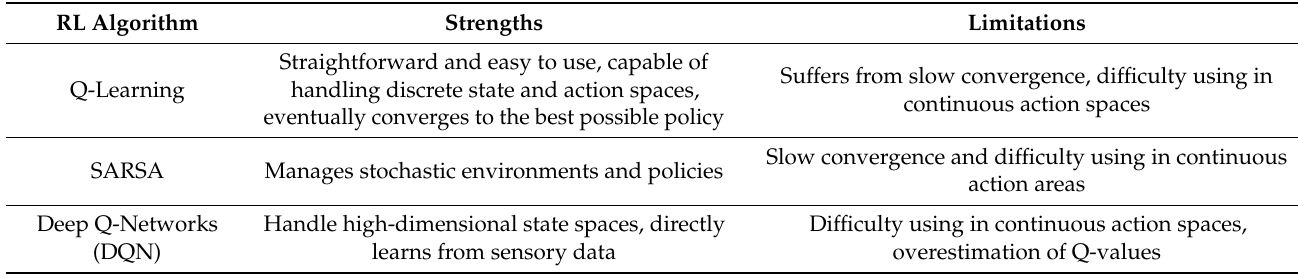
Table 3. The strengths and limitations of different RL